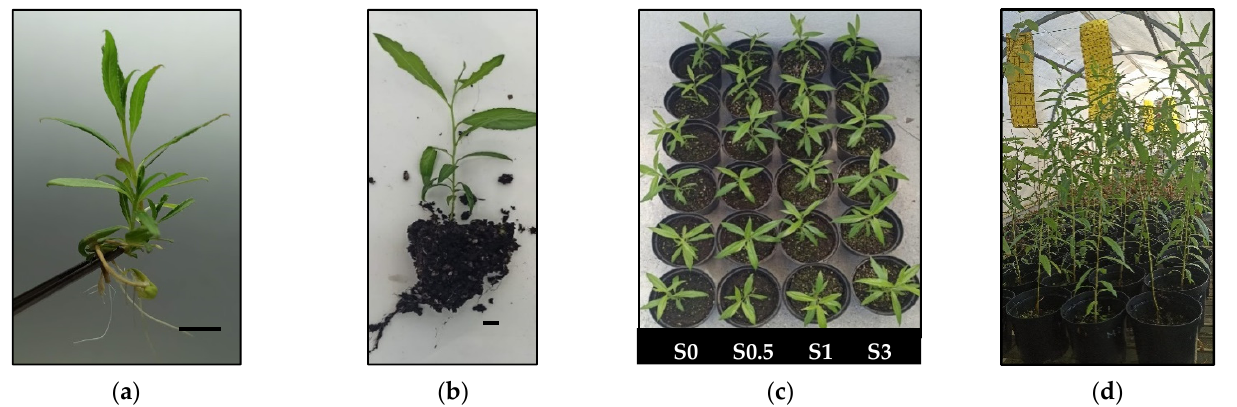
Figure 7. Acclimatization of willow shoots micropropagated in bioreactors in PAM conditions. ( a , b ) Apical sections cultured without sucrose at the moment of transfer to ex vitro conditions ( a ) and after 3 weeks in a phytotron ( b ). Plantlets cultured with 0, 0.5, 1 and 3% sucrose after 3 weeks in a phytotron and 2 weeks in a greenhouse ( c ). Plantlets after 9 weeks in the greenhouse ( d ). Bars 10 mm.